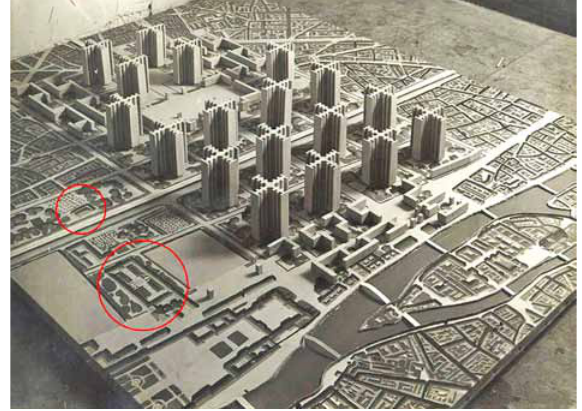
fig. 20. Photograph of the model published in Ville Redieuse 1933. ©